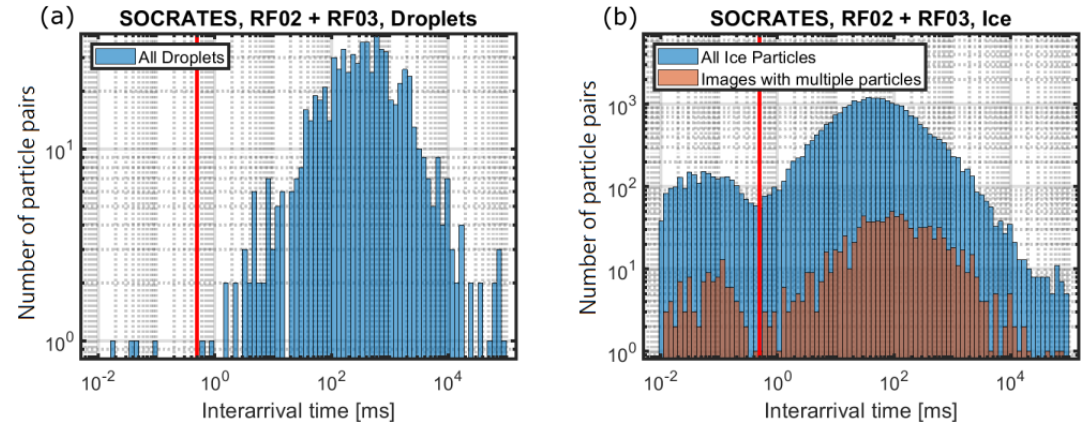
Figure 11. Histogram of interarrival times of ice particles (a) and droplets (b) measured during SOCRATES flights RF02 and RF03. Com- parison of the interarrival times of all particles (blue) and only particles whose images were manually classified as shattering events (red). The red vertical line marks the τ ≤ 0 . 5ms